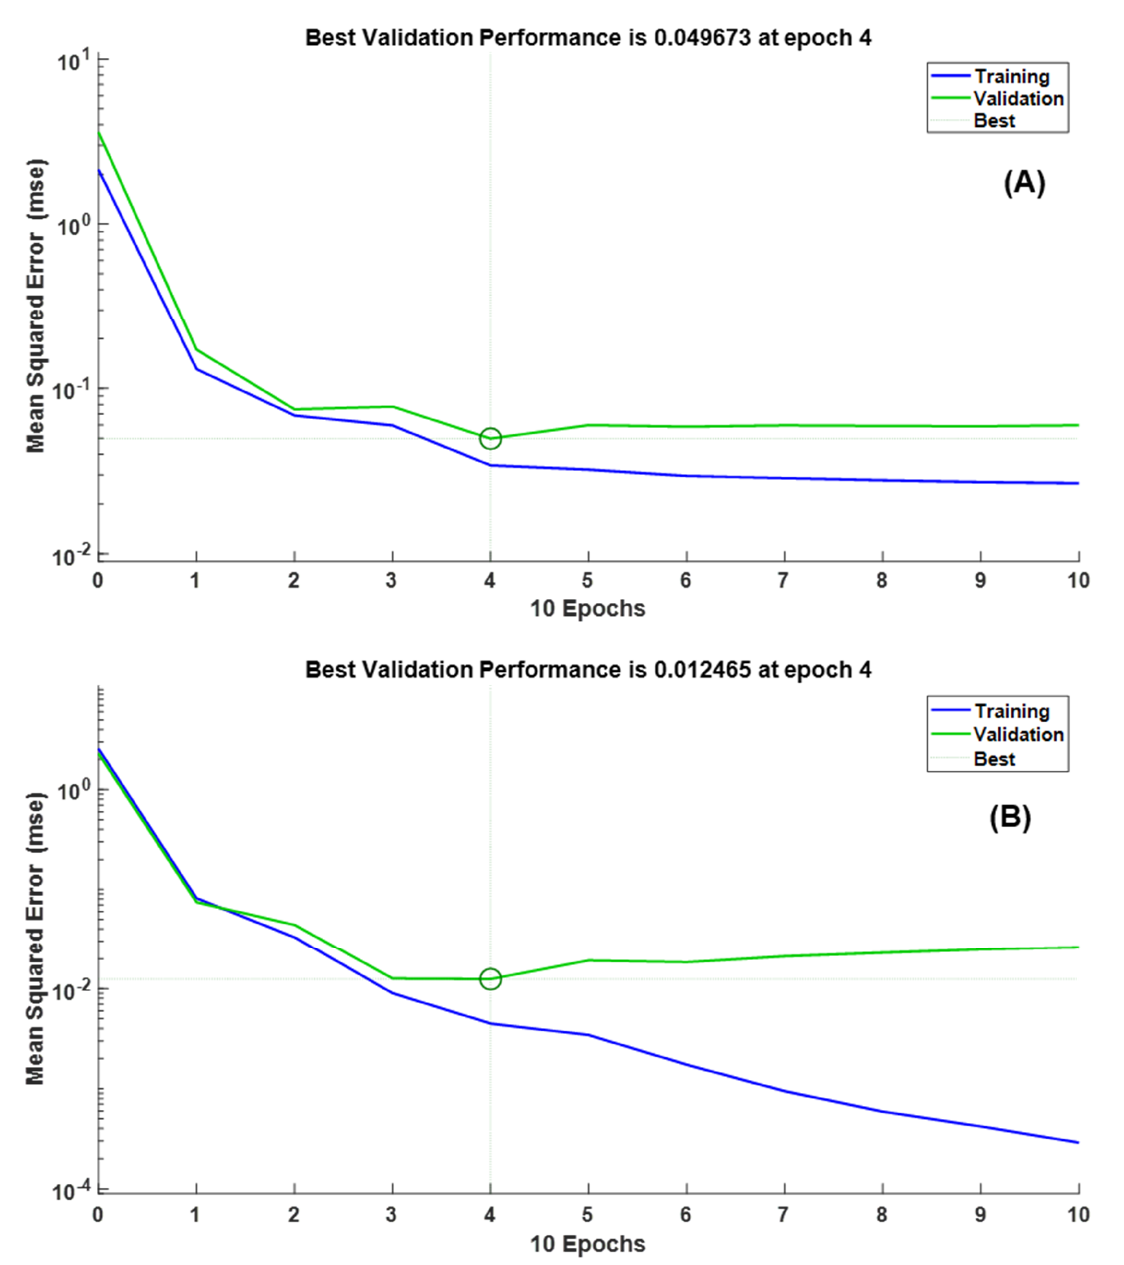
Figure 6. Variations in the mean squared error for different epochs in the training and validation periods for the ( A ) 12-month and ( B ) 24-month drought forecast models.